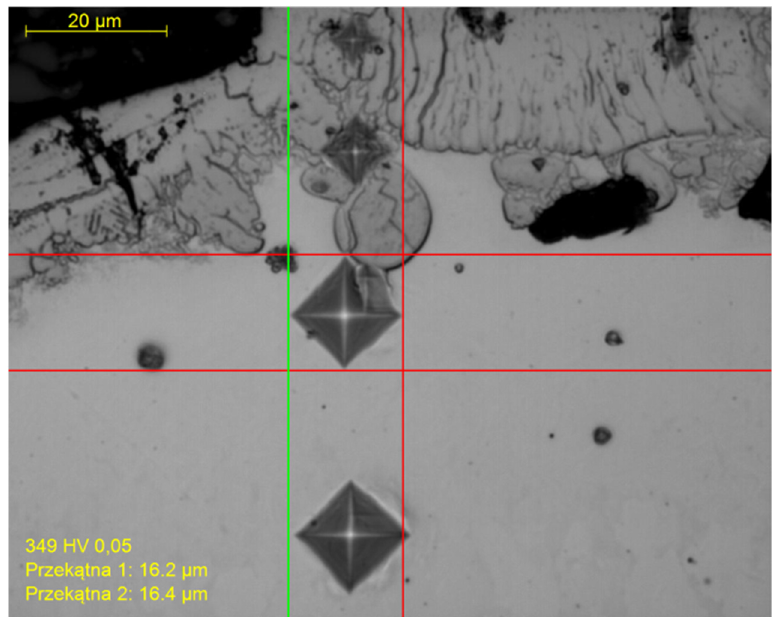
Figure 14. Vickers microhardness